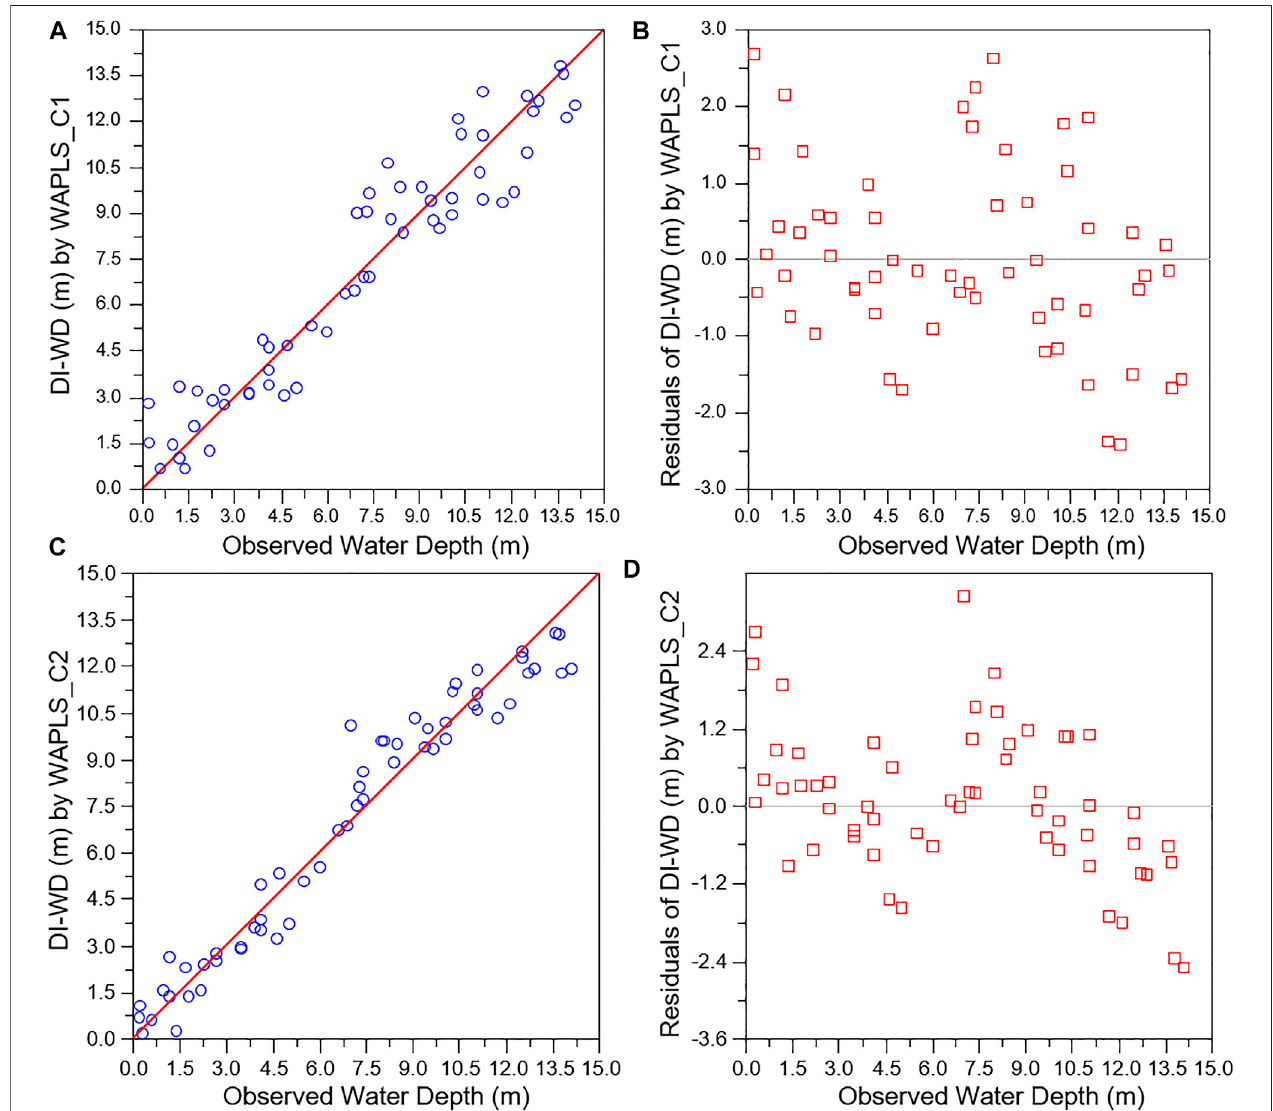
FIGURE5| Performanceofthediatom-inferredwaterdepth(DI-WD)transferfunctionforYunlongLake,constructedbyWAPLS(Components1,2). (A) Regression analysisresultsoftheDI-WDusingComponent1andthemeasureddataset. (B) ResidualsoftheDI-WDusingComponent1. (C) ResultsofregressionanalysisoftheDI- WD using Component 2 and the measured dataset. (D) Residuals of the DI-WD using Component 2.